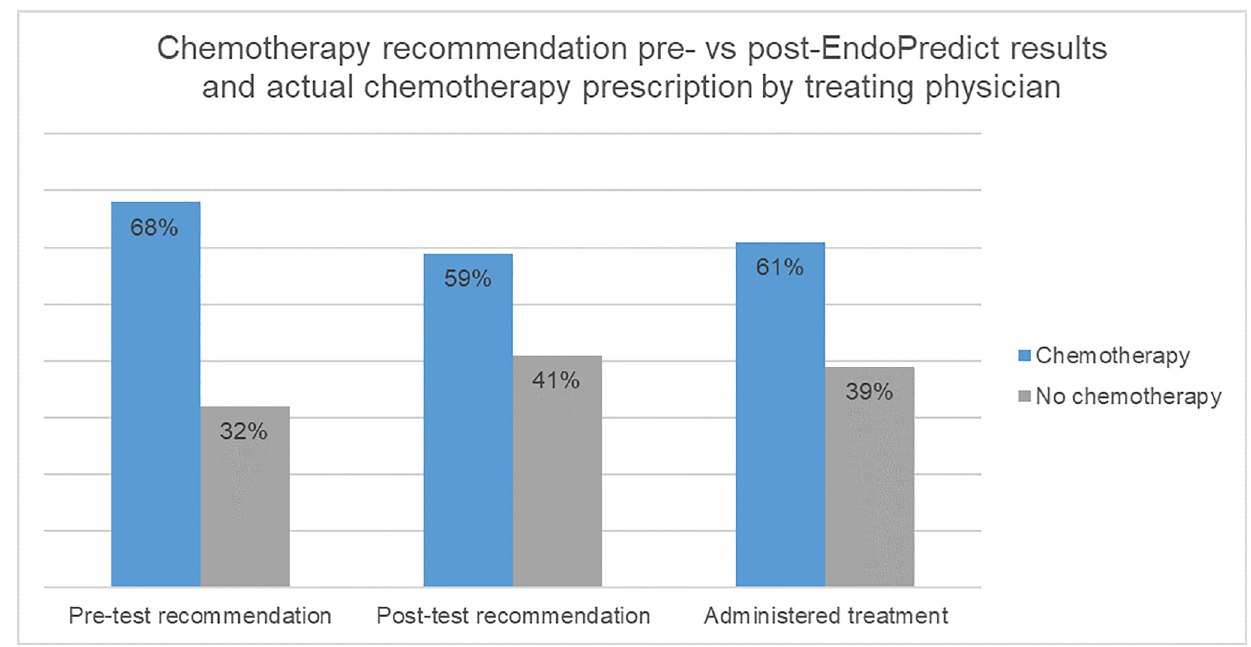
Fig 4. Chemotherapy recommendation pre- vs. post-EndoPredict results and actual chemotherapy prescription by treating physician.